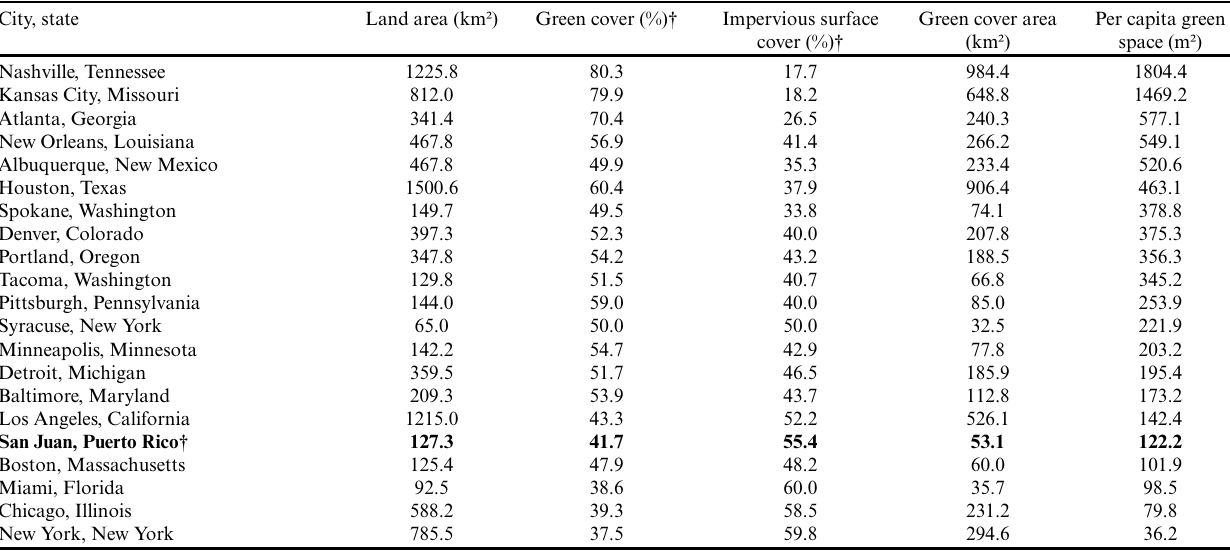
Table 3. Land area characteristics of the city of San Juan compared to 20 other reference cities in the United States as determined by Nowak and Greenfield (2012). Population and land area data are taken from 2007 U.S. census data (U.S. Census Bureau 2008). The list is ranked from largest to smallest per capita green space. The city of San Juan is indicated in boldface font. City, state